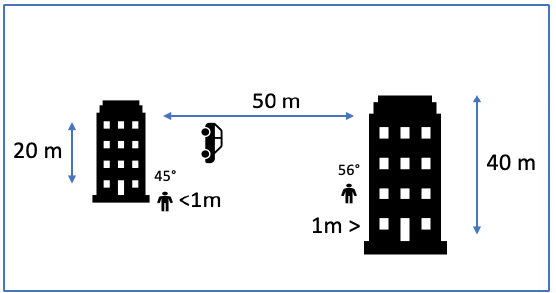
Figure 5. View of the sky (angle in degrees), as presented in Reference